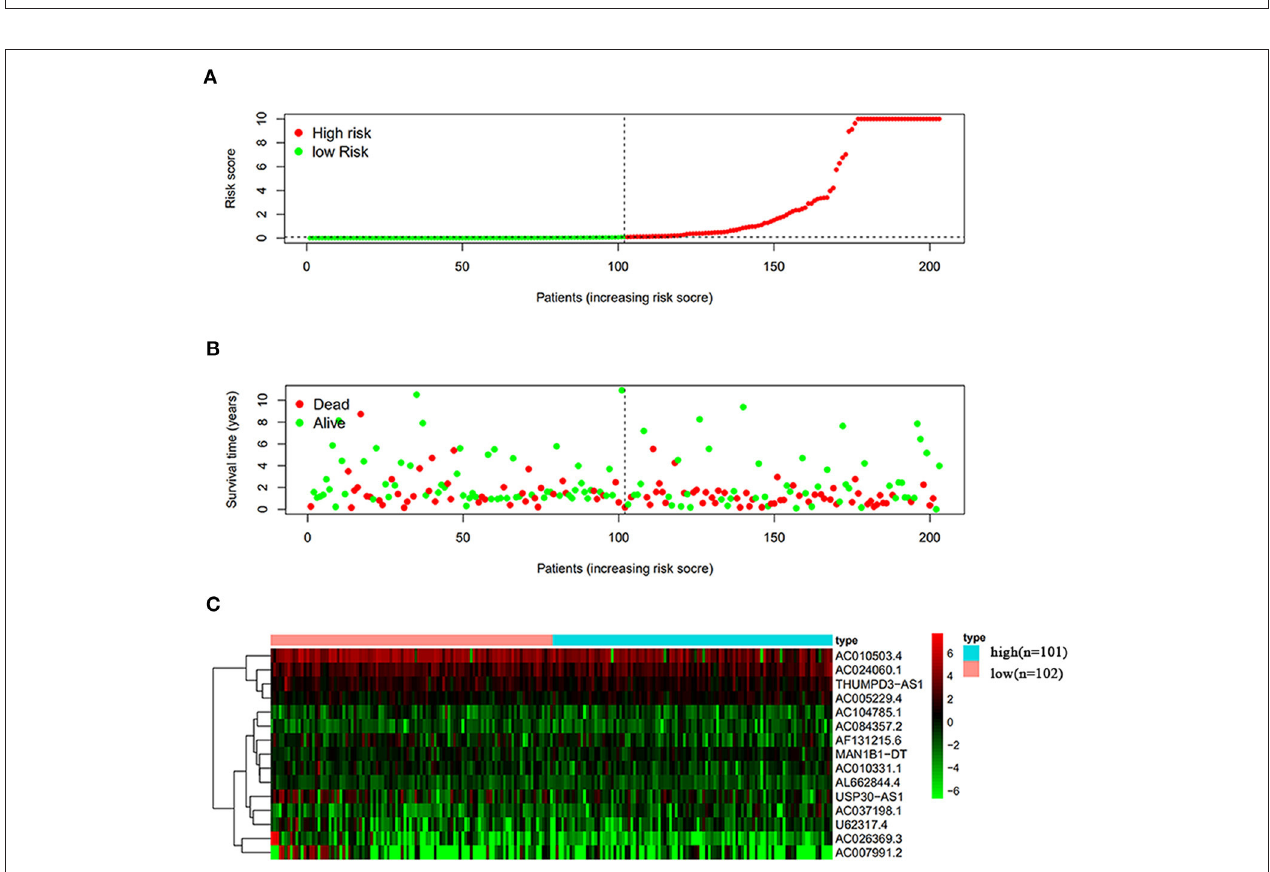
FIGURE 6 | Analysis of autophagy-related lncRNA risk scores of patients with BC in TCGA testing group. (A) Autophagy-related lncRNA low-risk group ( n = 102) and high-risk group ( n = 101) in patients with BC. (B) Survival status and duration of BC cases. (C) Heat map of the expression of 15 key lncRNAs in BC. The color from green to red shows the expression trend from low level to high